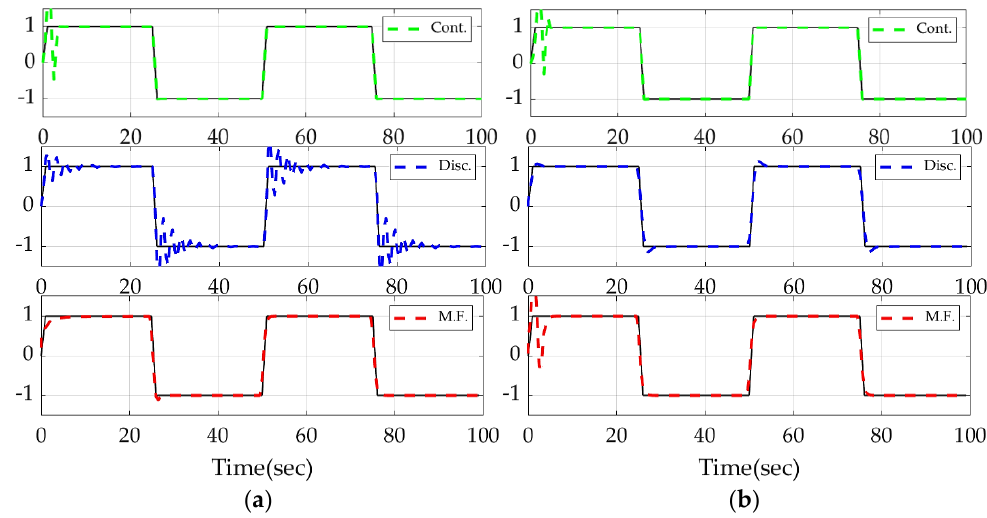
Figure 7. The output signals generated by all modeling approaches at step-sizes of 0.50 and 0.27 s. The detailed figure schemes for ( a ) and ( b ) follow the previous descriptions provided under Figures 1 and